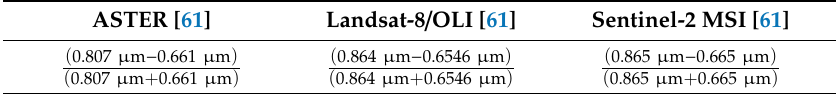
Table 1. NDVI formulation for ASTER, Landsat-8 / OLI, and Sentinel-2 MSI images expressed in